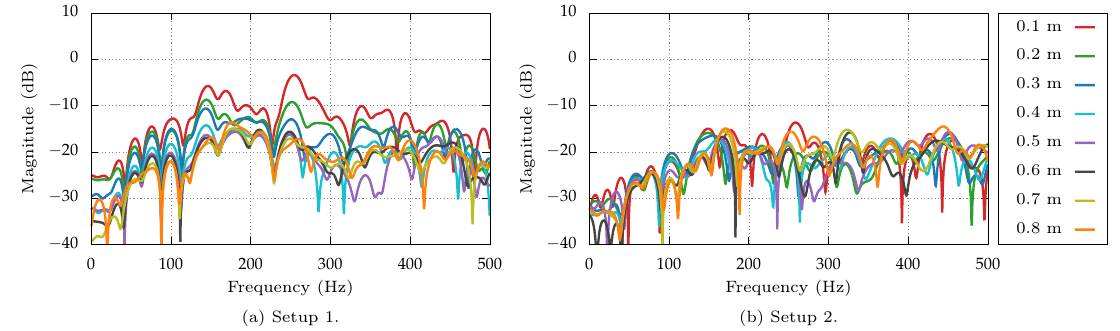
Figure 8. The amplitude functions of the frequency functions of the impulse response estimates for the secondary paths between right casing panel’s selected actuator and the error microphone adjacent to the right casing panel, at all distances, in both setups.